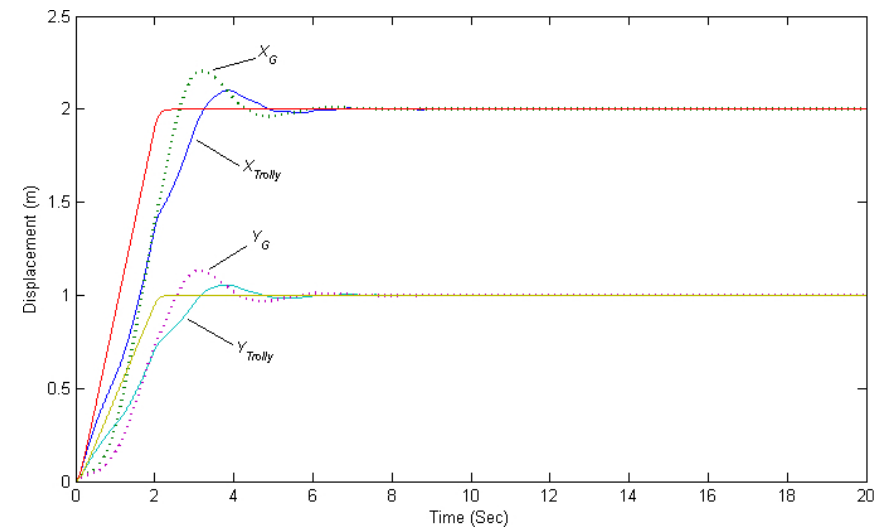
Figure 6. Response to planar trolley motion under WBC (sub G : mass centre of distributed